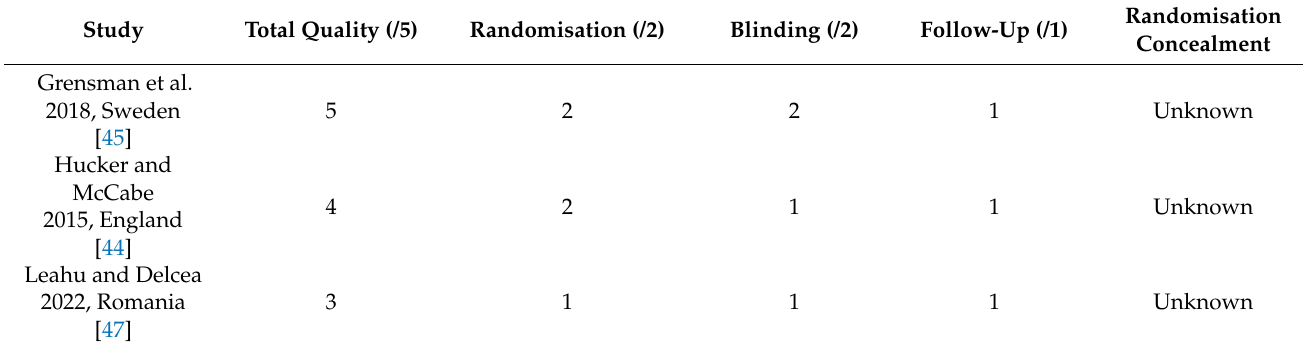
Table 3. Jadad scale for a randomized control